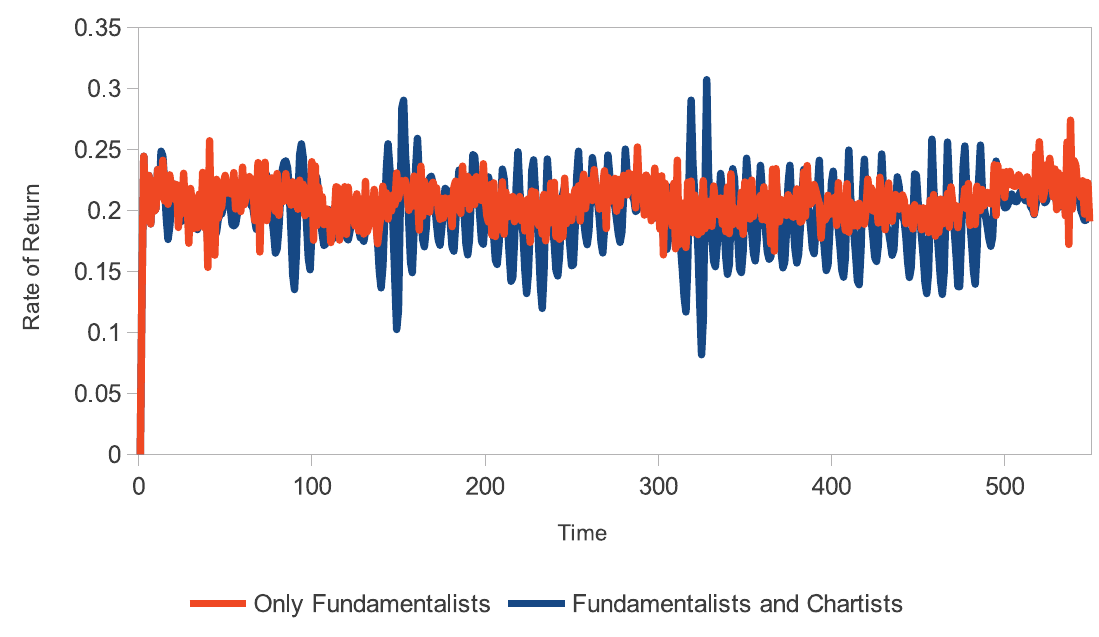
Fig 2. Evolution of the stock rate of return (different types of agents). Source: Own